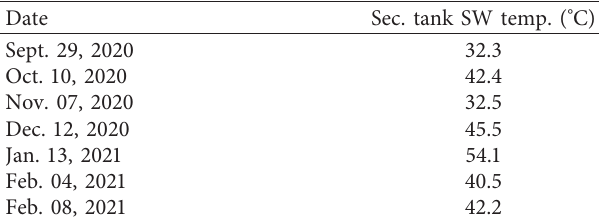
Table 3: Secondary SW tank